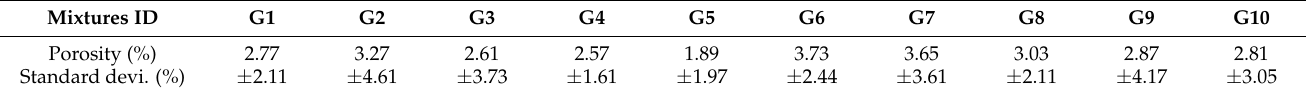
Table 6. Average porosity of UHPGC mixtures.